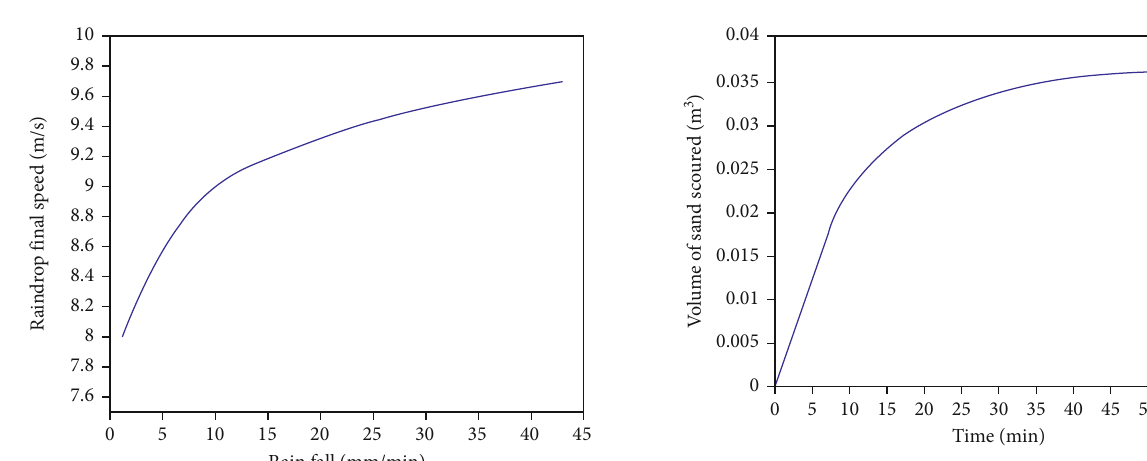
Figure 7: Changes in the amount of sand washed away by precipitation.